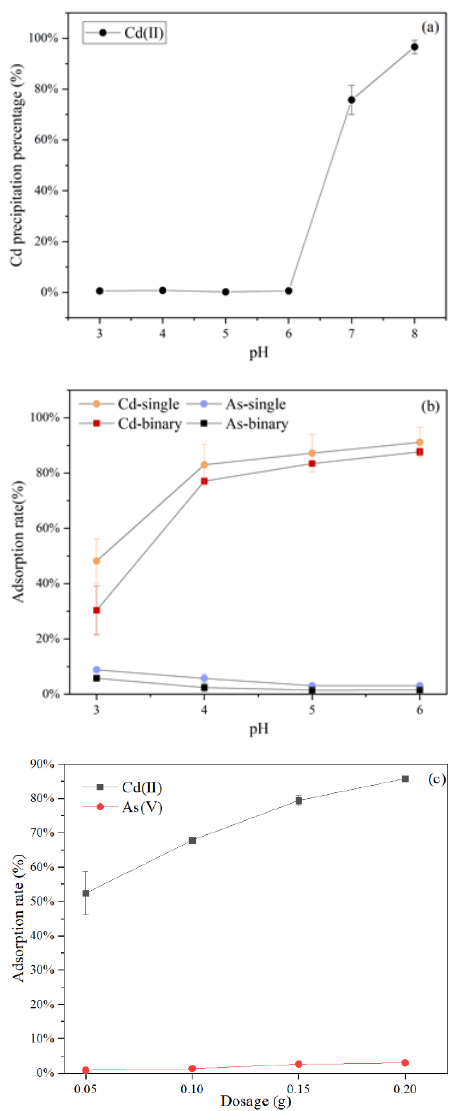
Figure 1. The image of the As(V) and Cd(II) precipitation curves: ( a ) Effects of pH on co-precipitation, ( b ) biosorption by C. vulgaris for the single and binary solution systems, and ( c ) adsorbents dosage on adsorption by C. vulgaris for the binary solution systems.